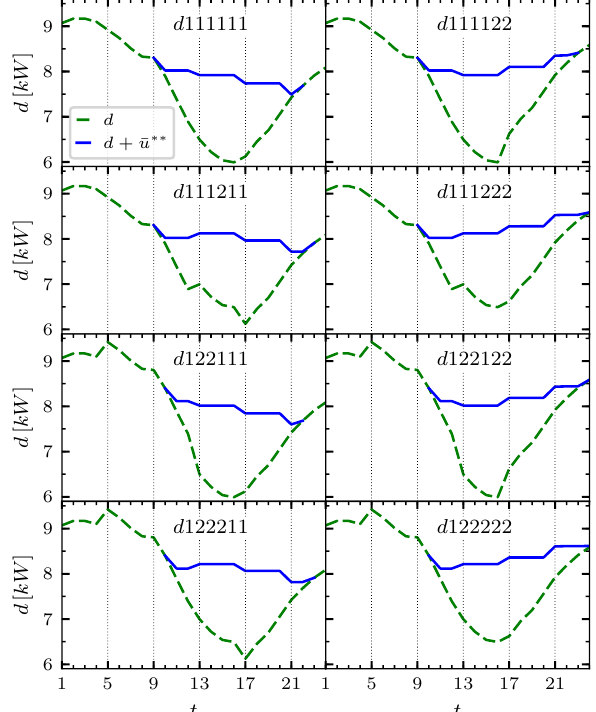
Figure 4. Total aggregated demand d + ¯ u ∗∗ at the social optimum (blue curve) and non-PEV demand d (green dashed curve) for eight different scenarios. The aggregated demand ¯ u ∗∗ for the remaining twenty-four scenarios reduces to the eight curves shown